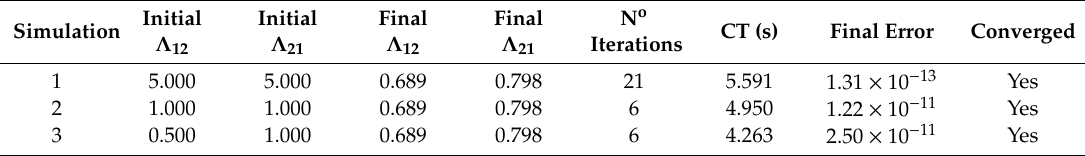
Figure 4. Proposed algorithm for the solution of the problem based on Broyden’s method. Table 5. Results for simulation by using Broyden’s method.